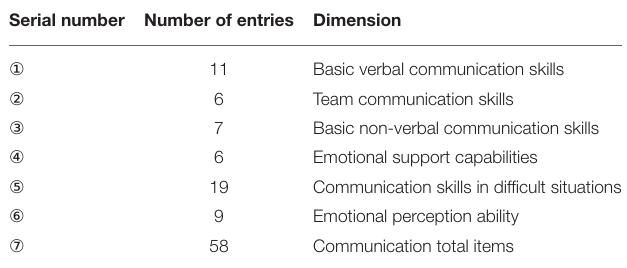
TABLE 2 | NCCCS scale of new nurses.